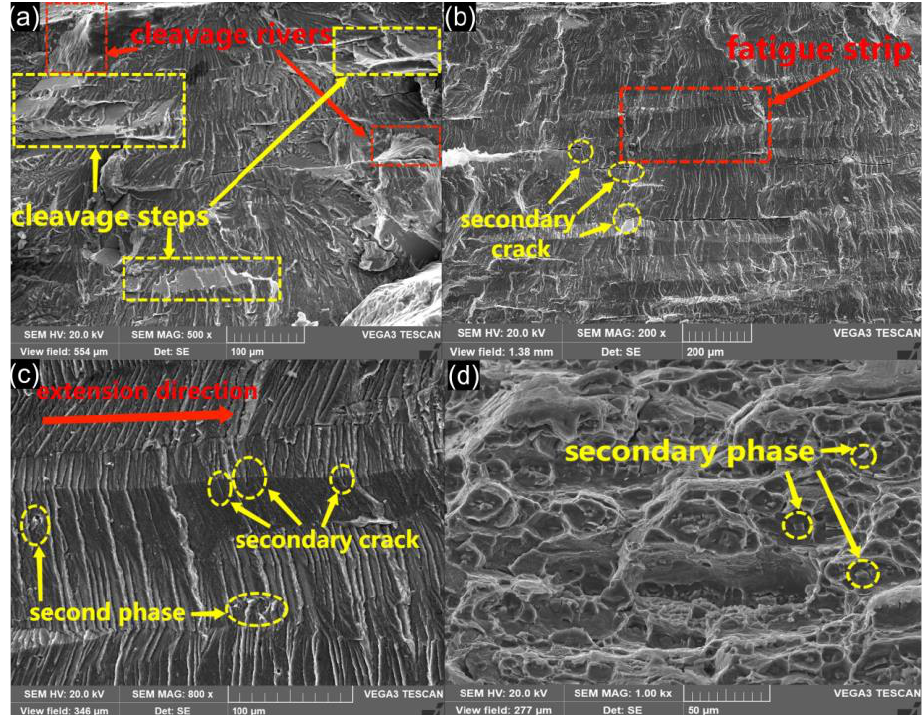
Figure 8. SEM image: ( a ) cleavage river and cleavage step, ( b ) fatigue crack growth zone, ( c ) fatigue bands, ( d ) base metal dimple.